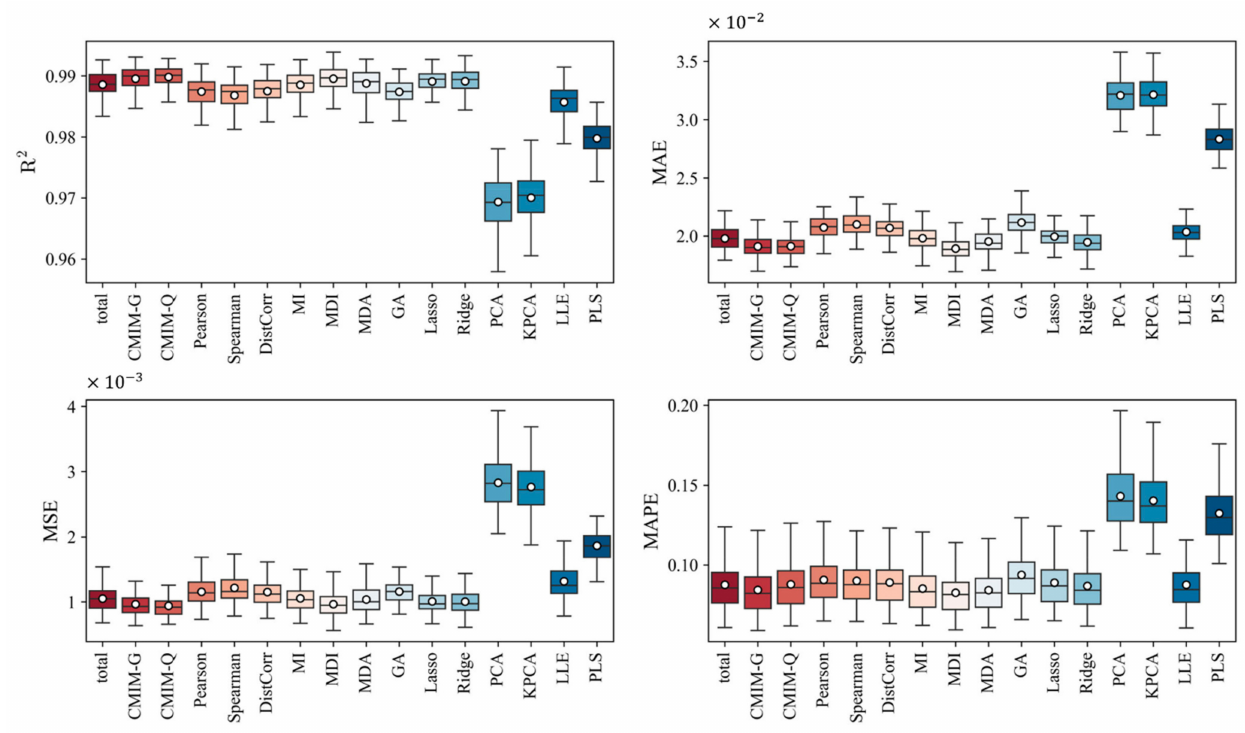
Figure 7. Comparison of metrics obtained by different methods with RF on Y LD .